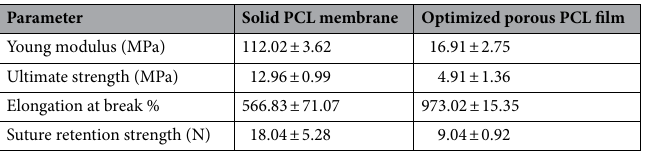
Table 3. The mechanical properties and suture retention strength of porous PCL Film compared to a solid PCL membrane.